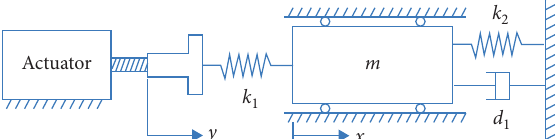
Figure 2: Schematic diagram of the mechanical system dynamics